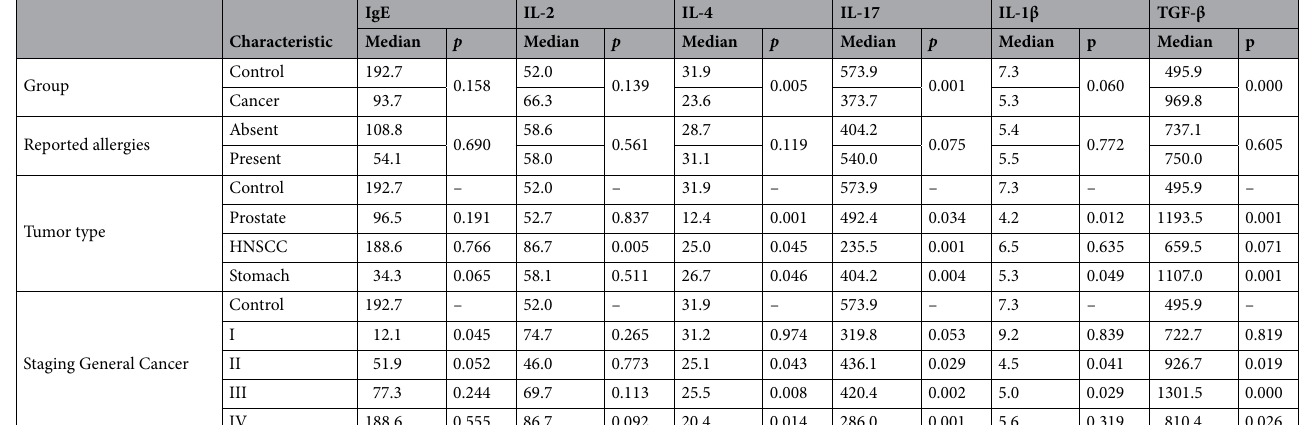
Table 2. Relationship among cancer, reported allergies, IgE (UI/ml), and cytokine (pg/ml) concentration. Kruskal–Wallis test. Comparisons in relation to the Control Group, or to the Reported Allergies Absent Subgroup. Values are presented as median. Groups: Control (n = 20) and General Cancer (n = 60), that was the sum of three subgroups: Prostate (n = 20), HNSCC (n = 20), and Stomach (n = 20) Cancer. Reported allergies absent (n = 48) and present (n = 22). Staging General Cancer I (n = 3), II (n = 14), III (n = 23), IV (n = 20). Abbreviations: IgE = immunoglobulin E, IL = interleukin, TGF = transforming growth factor, HNSCC = head and neck squamous cell carcinoma. Staging based on AJCC Cancer Staging Manual, 8th ed. 43